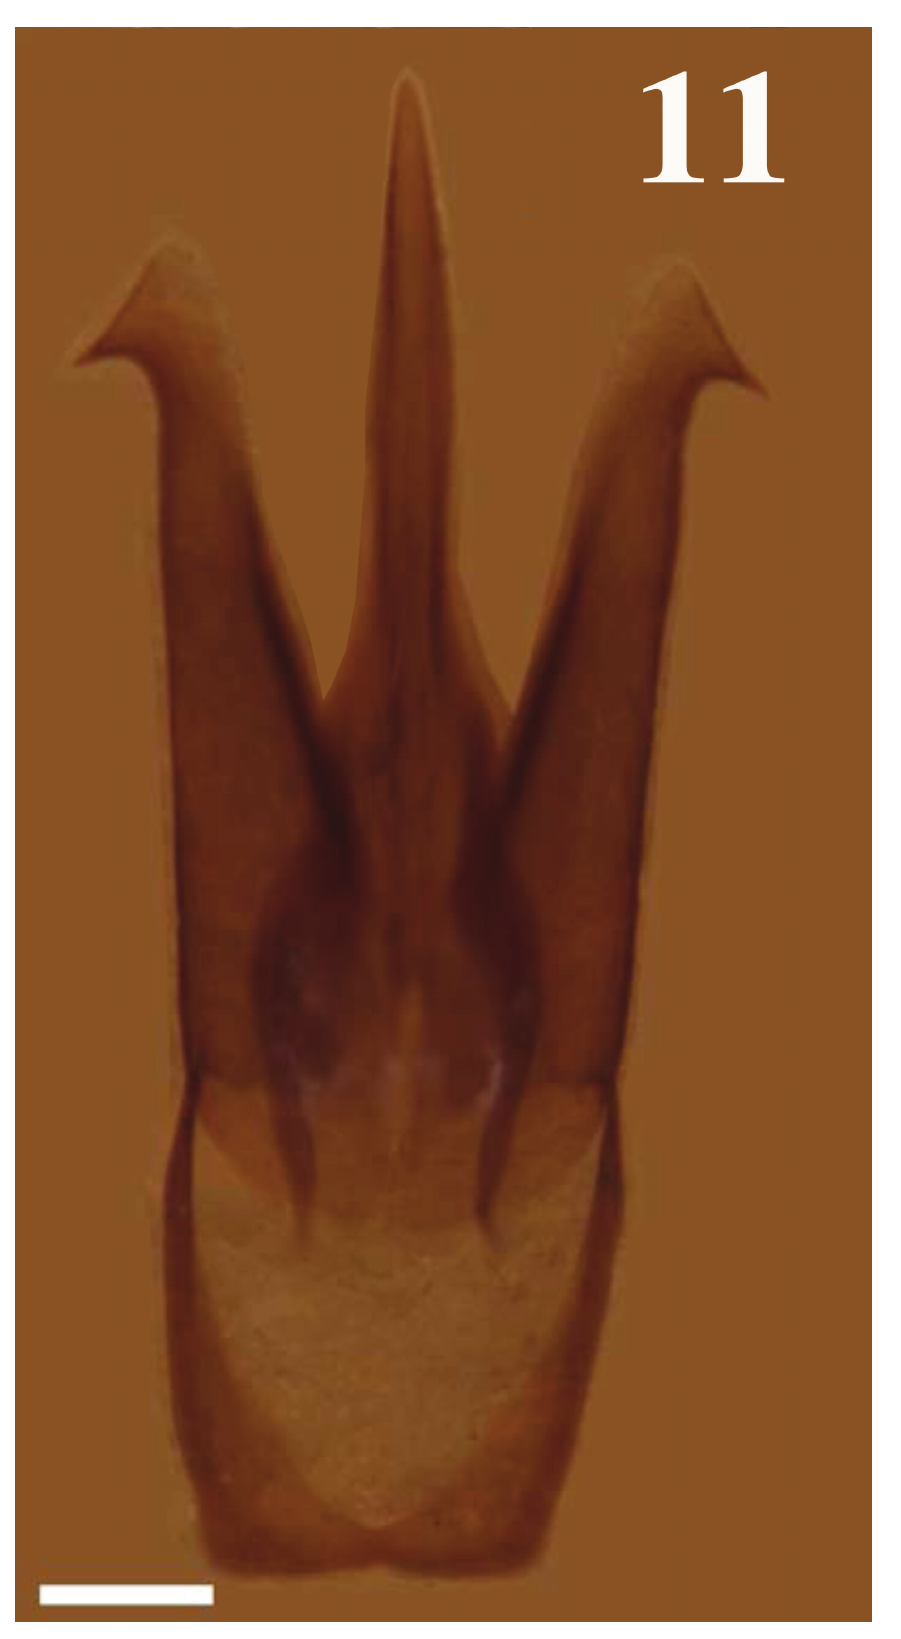
Fig. 11. Male genitalia of Sharon amoenus (Philippi, 1861) comb. nov. scale bar = 0.5